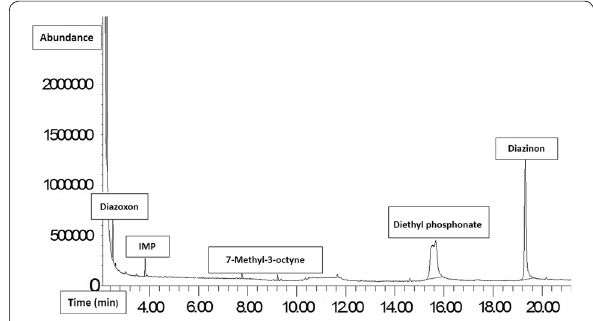
Fig. 5 Gas chromatography–mass spectrometry of diazinon